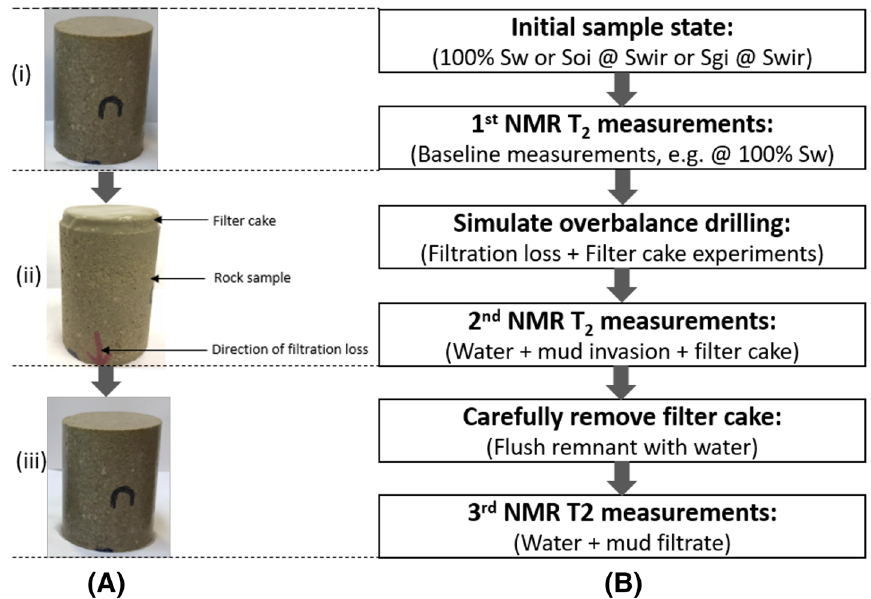
Fig. 3 A Rock sample with filter cake deposited on the surface area and B flowchart of experimental